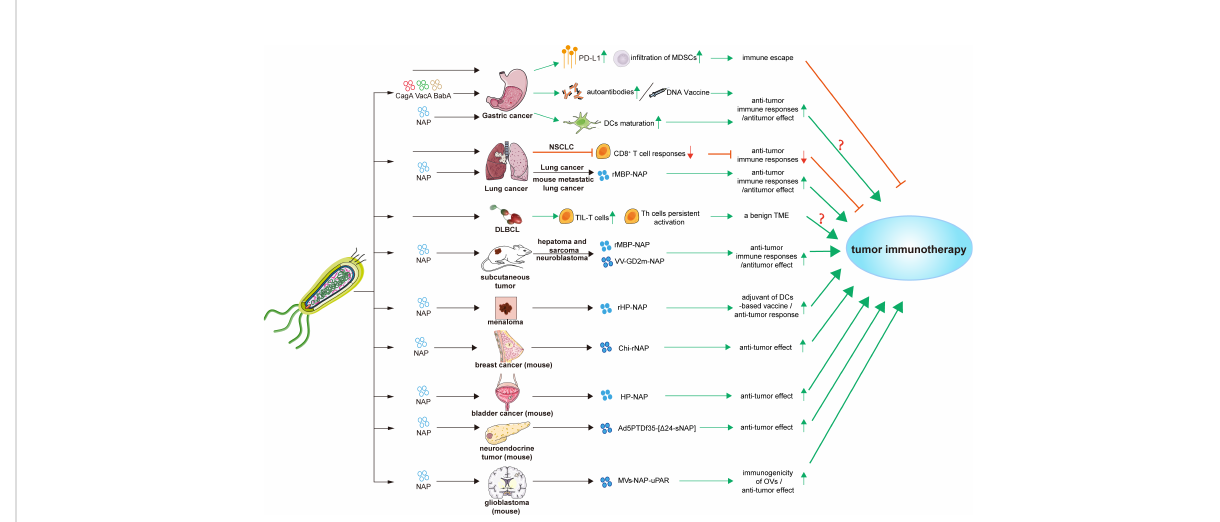
FIGURE 2 Effects and applications of H. pylori and its factors in tumor immunotherapies. Bab A, blood-group antigen-binding adhesin gene A; Cag A, cytotoxin-associated gene A; Chi-rNap, rNAP coated chitosan nanoparticles; DCs, dendritic cells; DLBCL, diffuse large B-cell lymphoma; HP- NAP, H. pylori neutrophil-activating protein; MDSCs, myeloid-derived suppressor cells; MV-NAP-uPAR, recombinant measles virus-NAP- urokinase-type plasminogen activator receptor; NSCLC, non-small cell lung cancer; OVs, oncolytic viruses; PD-L1, programmed death-ligand 1; rHP-NAP, recombinant H. pylori neutrophil-activating protein; rMBP-NAP, recombinant HP-NAP with the maltose-binding protein of Escherichia coli; Th cells, T helper cells; TIL-T cells, tumor-in fi ltrating T lymphocytes; TME, tumor microenvironment; Vac A, vacuolating cytotoxin A; VV-GD2m-NAP, vaccinia virus - neuroblastoma-associated antigen disialoganglioside